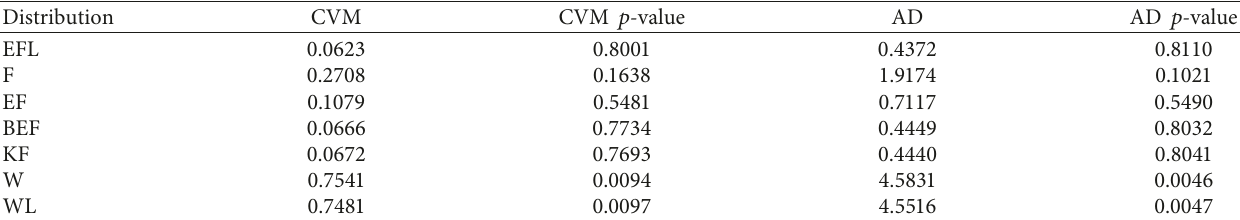
Table 7: Goodness-of-fit measures of estimated distributions for catastrophe